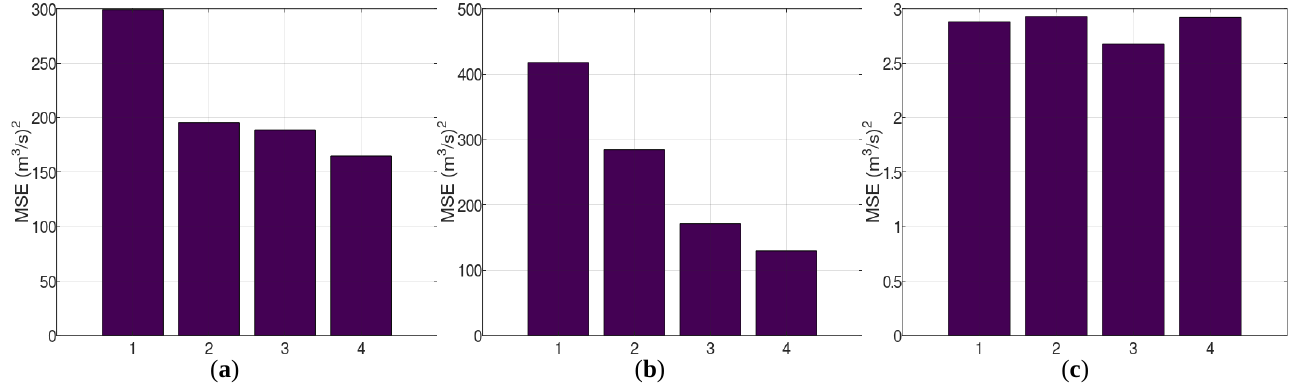
Figure 12. ( a ) Case studies of the Arno River, ( b ) Sieve River and ( c ) Bakas River. In all three panels: MSE of the HYMOD simulations (1st bar), LSTM with HYMOD simulations (2nd bar), LSTM with HYMOD+LRHM simulations (3rd bar) and LSTM with simulations of the best hydrological model (4th